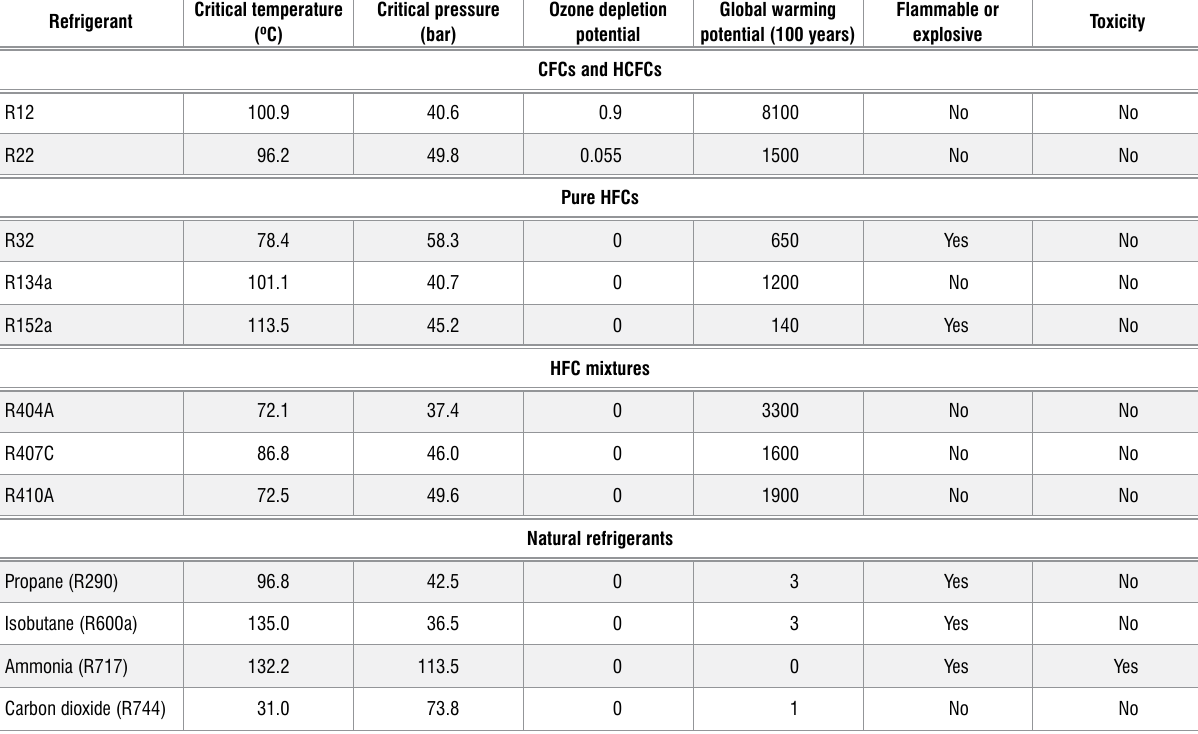
Table 1: Properties of some refrigerants 1,2